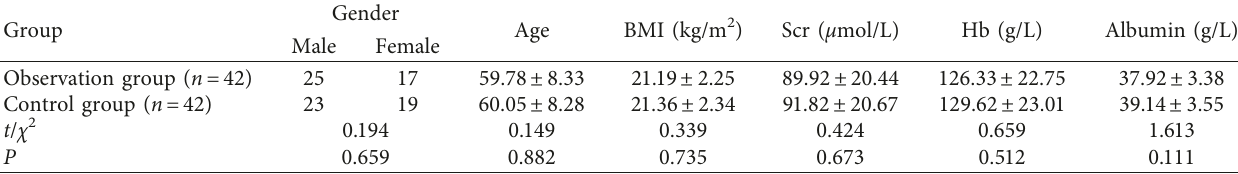
Table 1: Comparison of general data between the observation group and the control group ( n , x ± s ).